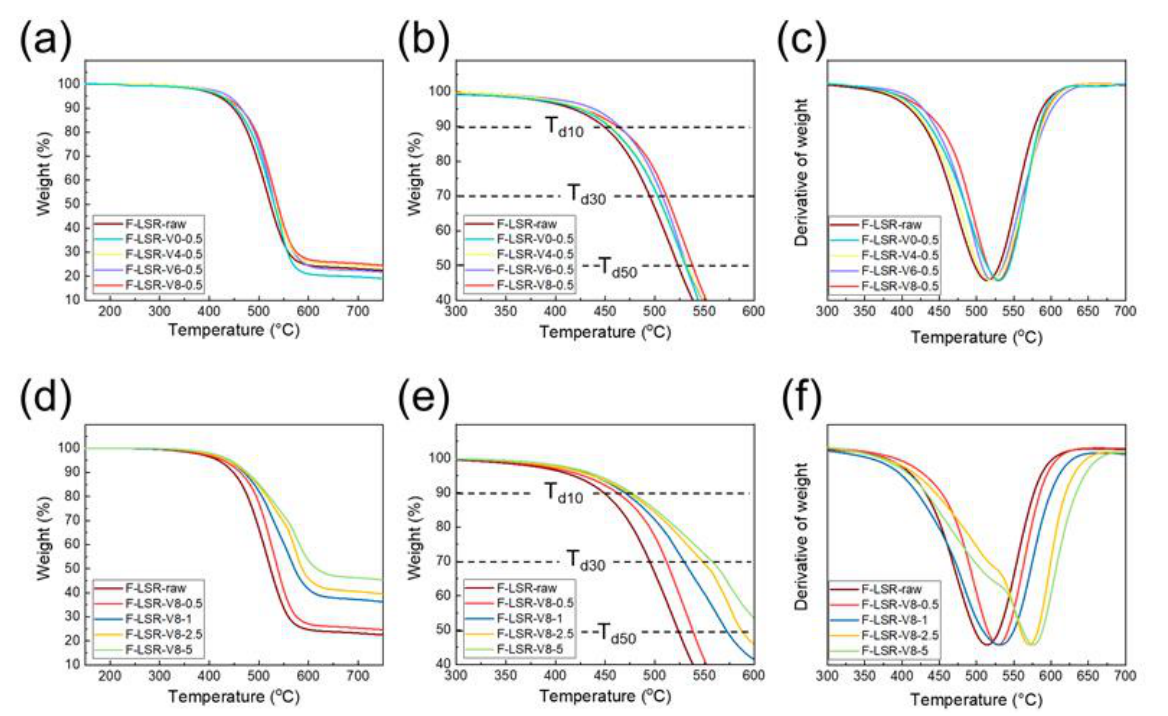
Figure 8. TGA analysis of the F-LSR-POSSs: ( a , b ) TGA thermograms of the F-LSR-POSSs with various types of POSSs; ( c ) DTGA of F-LSR-POSSs with various types of POSSs; ( d , e ) TGA thermograms of F-LSR-POSSs with different loadings of POSS-V8; and ( f ) DTGA of F-LSR-POSSs with different loadings of POSS-V8.